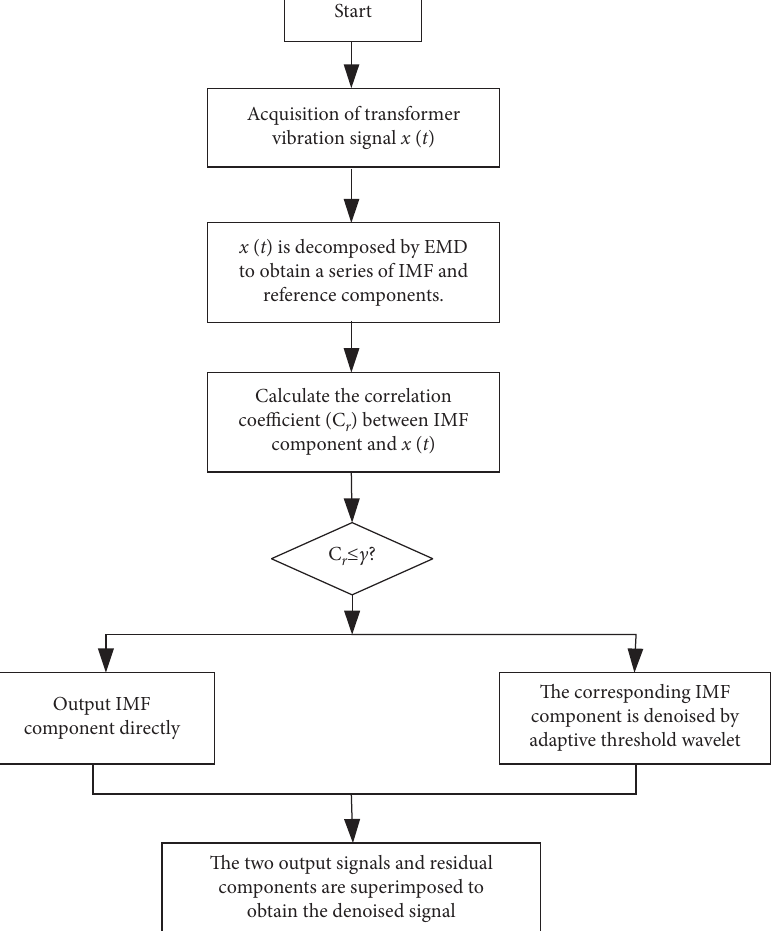
Figure 8: Flowchart of improved EMD and wavelet adaptive threshold denoising algorithm.